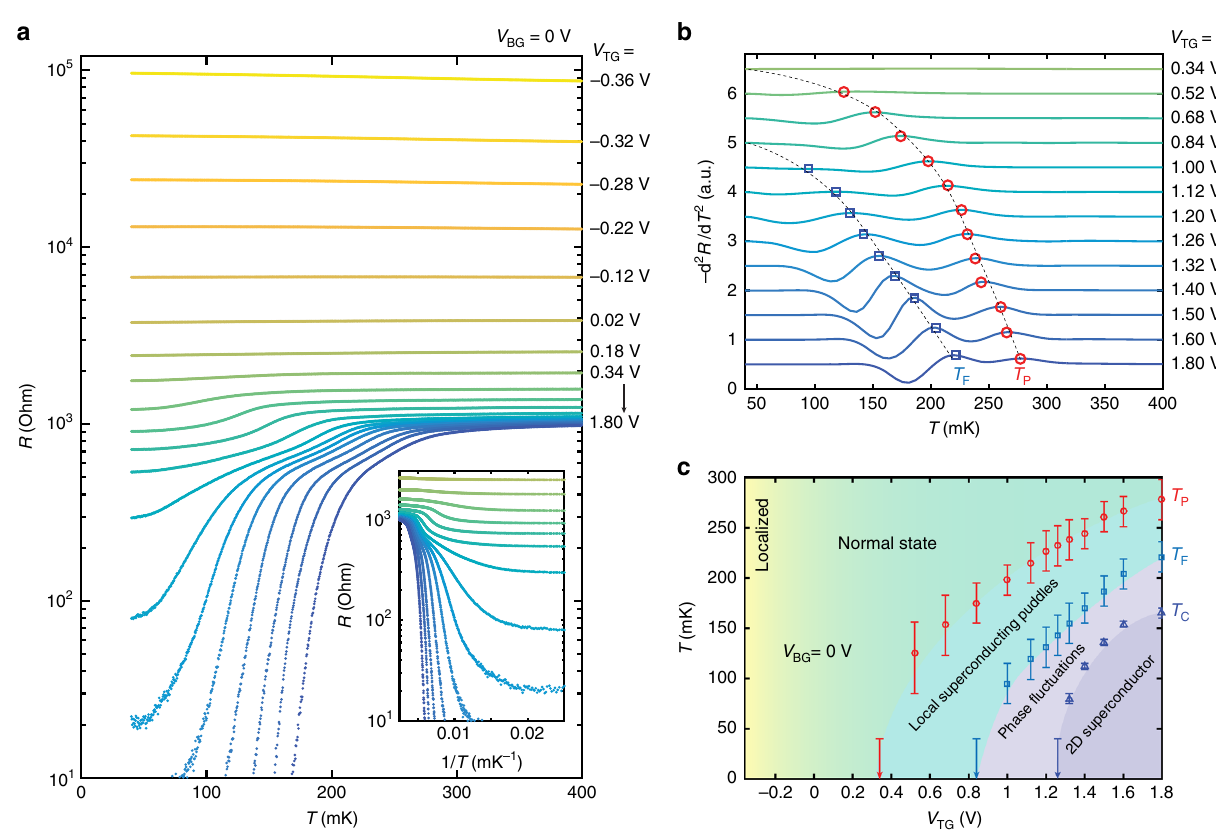
Fig. 2 Top-gate modulation of the interface ground state. a Sheet resistivity versus temperature ( R – T ) curves as a function of V TG from − 0.36 to 1.80 V with fi xed V BG = 0 V. Inset: magni fi cation of the data plotted against inverse temperature. b The second-order derivative calculated using a spline fi t of the R – T curves shown in a for V TG from 0.34 to 1.80 V. Red circles and blue squares indicate the local maxima of the peaks, de are matched between a and b . Dashed lines are guides to the eye. c Phase diagram extracted from a and b . Red circles, blue squares, and blue triangles represent T P , T F , and T C , respectively. Normal state here indicates a non-superconducting state. Error bars are de fi ned by the full width of the second derivative peaks for T P and T F . T C is de fi ned as the temperature at which the sheet resistivity drops to 1% of the normal-state resistivity R N (400 mK). The lowest temperature measured for our R – T curves is 40 mK, so data points estimated to be <40 mK are plotted with arrows. Background colours are guides to the eye indicating the different